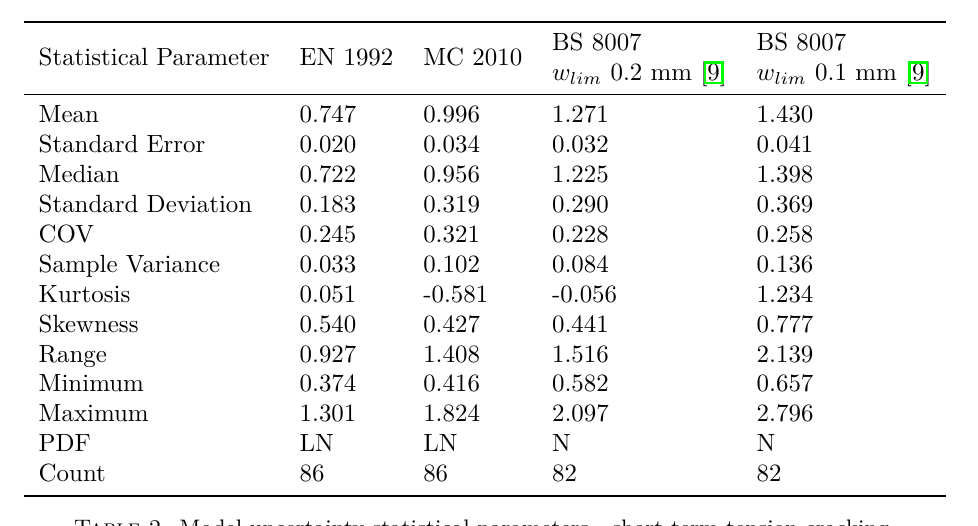
Table 2. Model uncertainty statistical parameters - short-term tension cracking.